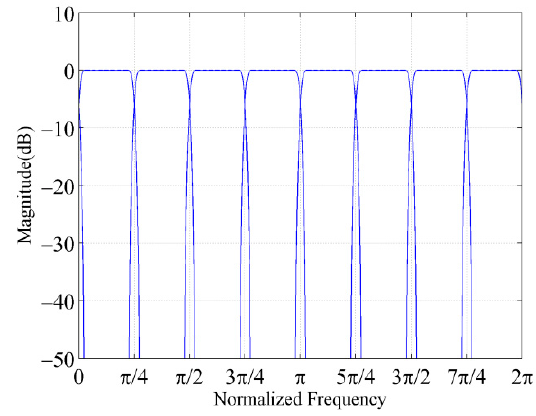
Figure 6. Ideal frequency response of the improved P-DFTFB.